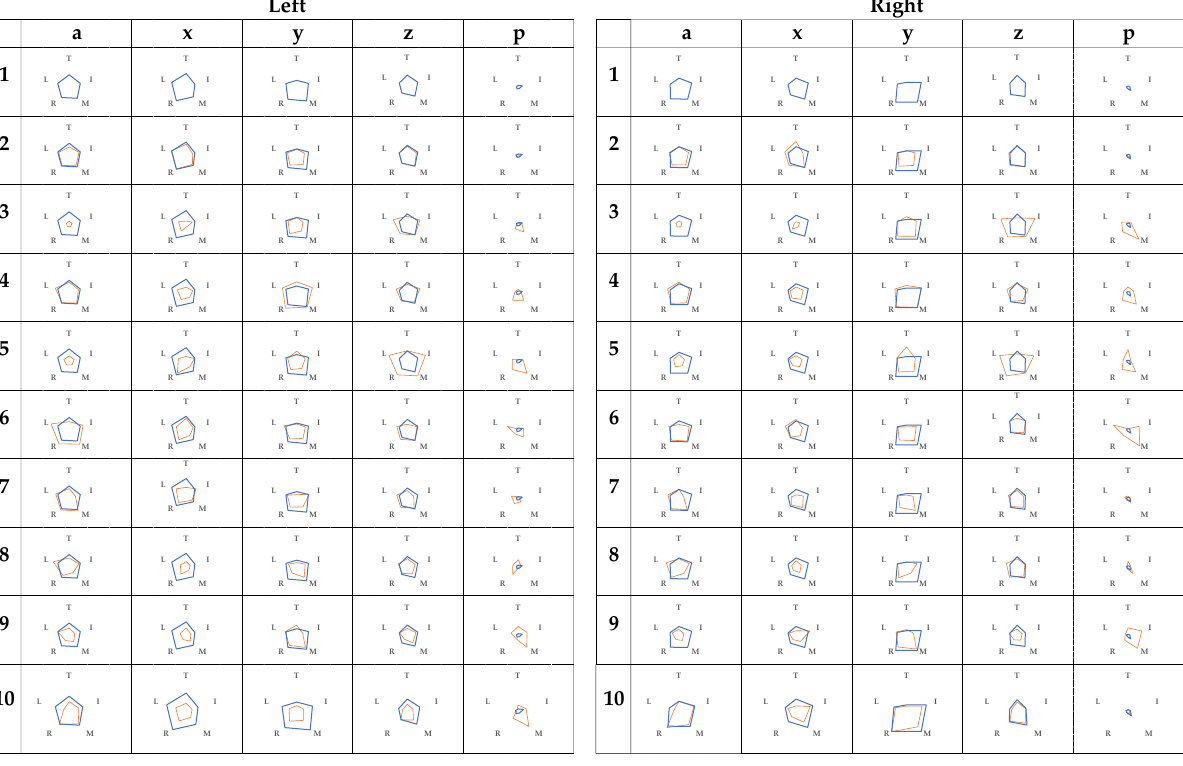
Figure 3. Radar charts of A (Top: thumb, clockwise, index, middle, ring, and little fingers).